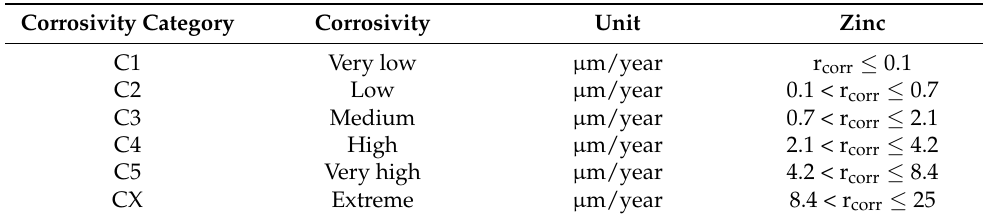
Table 1. Corrosion rates of zinc for first-year exposure for different corrosivity categories according to ISO